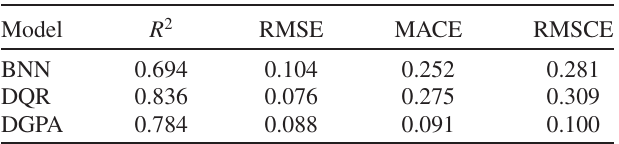
TABLE III. Out-of-distribution prediction performance for BNN, DQR, and DGPA models.